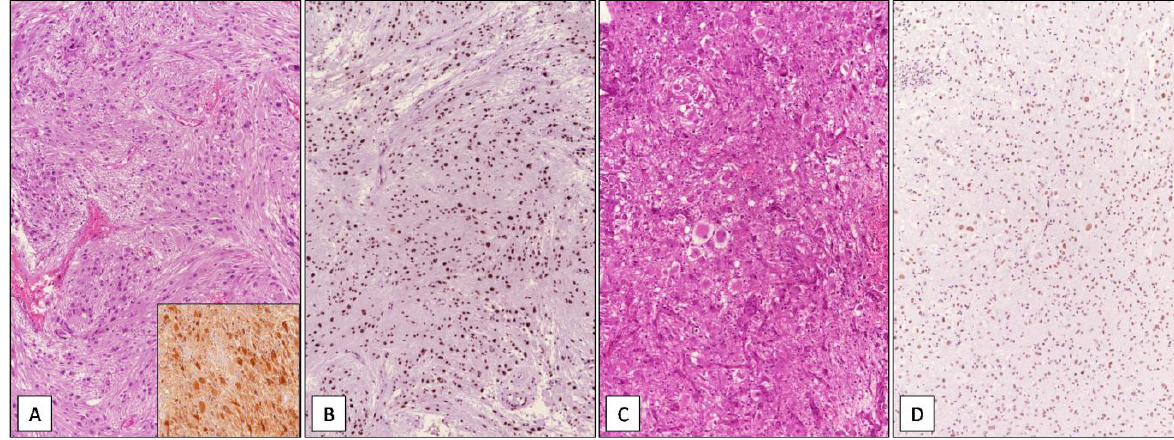
Figure 5. Sub-ependymal giant cell astrocytoma and pleomorphic xanthoastrocytoma. ( A ) Histopathological examination of sub-ependymal giant cell astrocytoma showing large polygonal to elongated cells with ganglioid/gemystocytic-like morphology and abundant eosinophilic cytoplasm; neoplastic cells typically exhibiting strong immunoreactivity for s-100 (insert); ( B ) strong and diffuse immunohistochemical expression of SRSF1 in sub-ependymal giant cell astrocytoma. ( C ) Histopathological examination of WHO grade II pleomorphic xanthoastrocytoma showing pleomorphic mono and multinucleated cells with focal cytoplasmic xanthomatous changes; ( D ) neoplastic cells were strongly and diffusely stained with SRSF1 (hematoxylin and eosin ( A , C ) and immunoperoxidase ( B , D ) staining; original magnifications 100 × ).